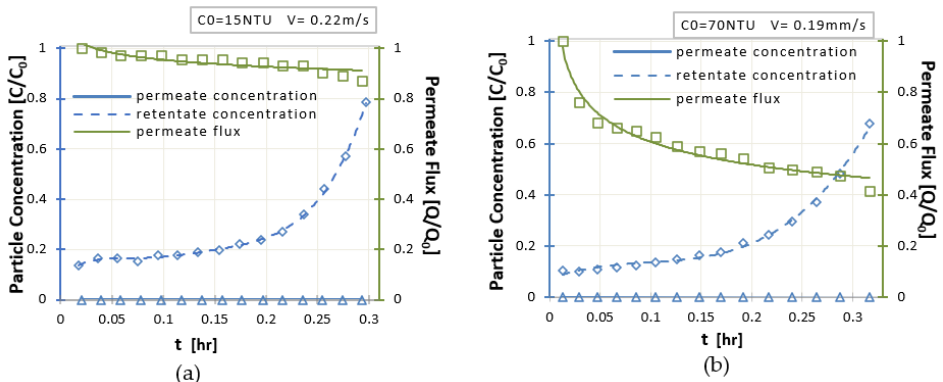
Figure 10. ( a ) Normalized particle concentration in the permeate (blue line) and in the retentate (dotted blue line) streams, normalized permeability flux (green line) for C 0 = 15Ntu and V = 0.22 m/s, ( b ) Normalized particle concentration at the permeate (blue line) and at the retentate streams (dotted blue line) and corresponding normalized permeate flux (green line), as functions of time for C 0 = 70NTU and V = 0.19 m/s.